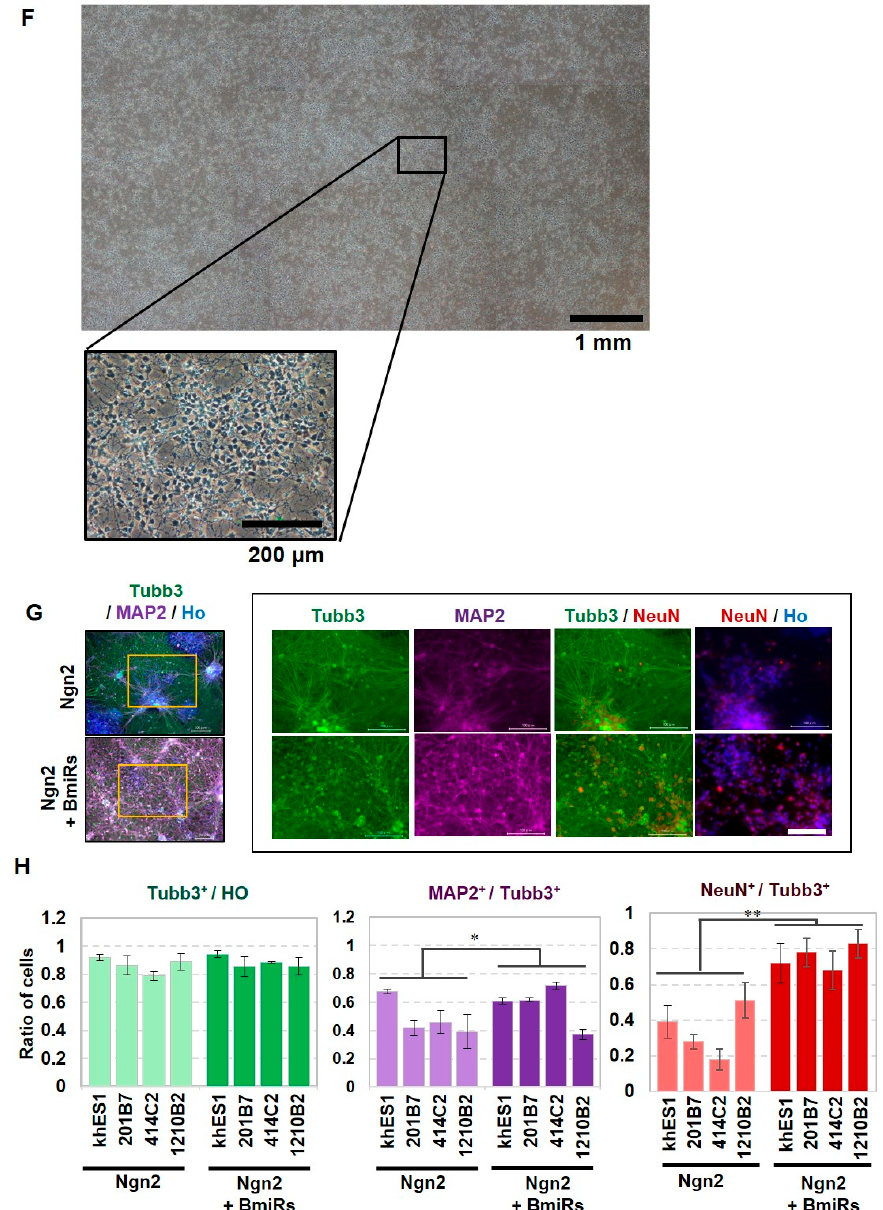
Figure 2. The effect of the combination of Ngn2 and BmiRs expression on neural differentiation. ( A ) The list of control hPSC line used in this study. ( B ) Overview of the protocol for piggybac vector transfection into hPSCs with the piggybac vectors. ( C ) Overview of the protocol for lentiviral infection into hPSCs and neuronal induction using Dox. ( D , E ) Design of the transposase expression vectors: Piggybac vectors for Ngn2-mediated neuronal conversion and lentiviral vector for Bcl-xL-miR-9 / 9*-124 -mediated neuronal conversion. Puro.R, Hygro.R, Blast.R, and rtTA3G indicates puromycin, hygromycin, blastcidin resistant sequences, and 3rd generation reverse tetracycline transactivator, respectively. ( F ) Representative low-power field (upper) and high-power field (lower) of the neurons (khES1) 20 days after transient expression of both Ngn2 and BmiRs. ( G ) Immunocytochemical analysis of neuronal markers (Tubb3, MAP2 and NeuN). The photograph on the right is an enlarged view of the part surrounded by yellow on the left. Scale Bar: 100 µm. ( H ) Ratio of positive cells for each marker: Tubb3 + cells/all cells (Tubb3+/Ho); MAP2 + cells/ neurons (MAP2+/Tubb3+); NeuN+ cells / neurons (NeuN+/Tubb3+) (n = 4 independent experiments; mean ± SD; * p < 0.05; ** p < 0.01, Dunnett’s test).